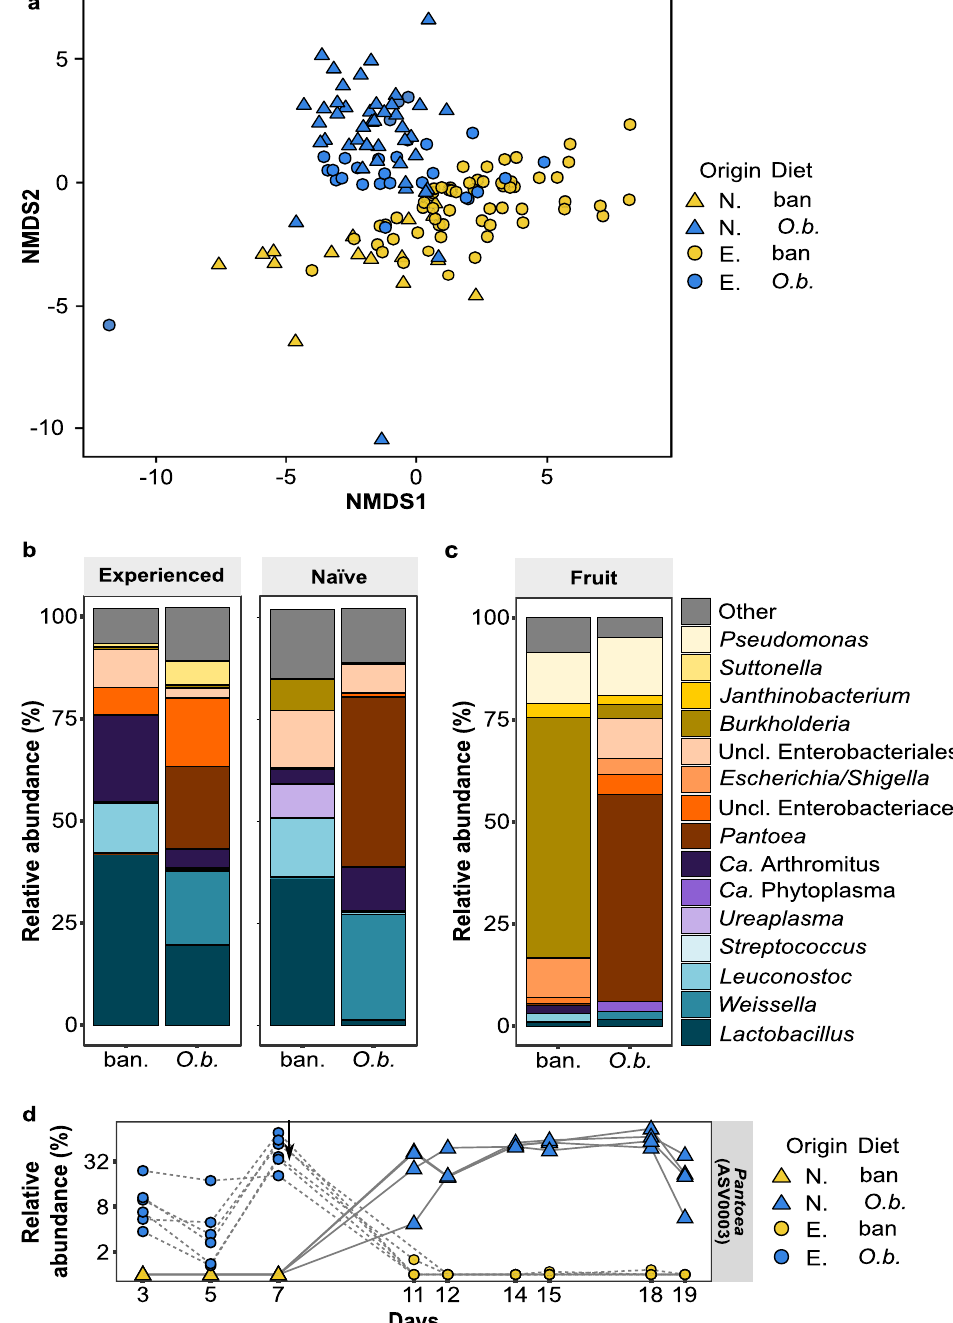
Fig.3|Thebirdgutmicrobiotaandrelativeabundanceof Pantoea arestrongly affected by the consumptionof Ochradenus baccatus fruits. a The differencein the microbiota composition of naïve (N.; triangles) and experienced (E.; Circles) birdsfeedingonbanana(ban.;Yellow)or O.baccatus fruits( O.b .;Blue).Non-metric multidimensional scaling analysis (NMDS) based on the Bray – Curtis dissimilarity matrix (Stress k =2 =0.12) reveals that capturing location and diet have a strong effect on shaping bacterial populations; permutational analysis of variance (PER- MANOVA), F =6.67, df=1, R 2 =0.074, P <0.001 and F =7.12, df=1, R 2 =0.079, P <0.001 for capturing location and diet, respectively. b Mean relative abundance